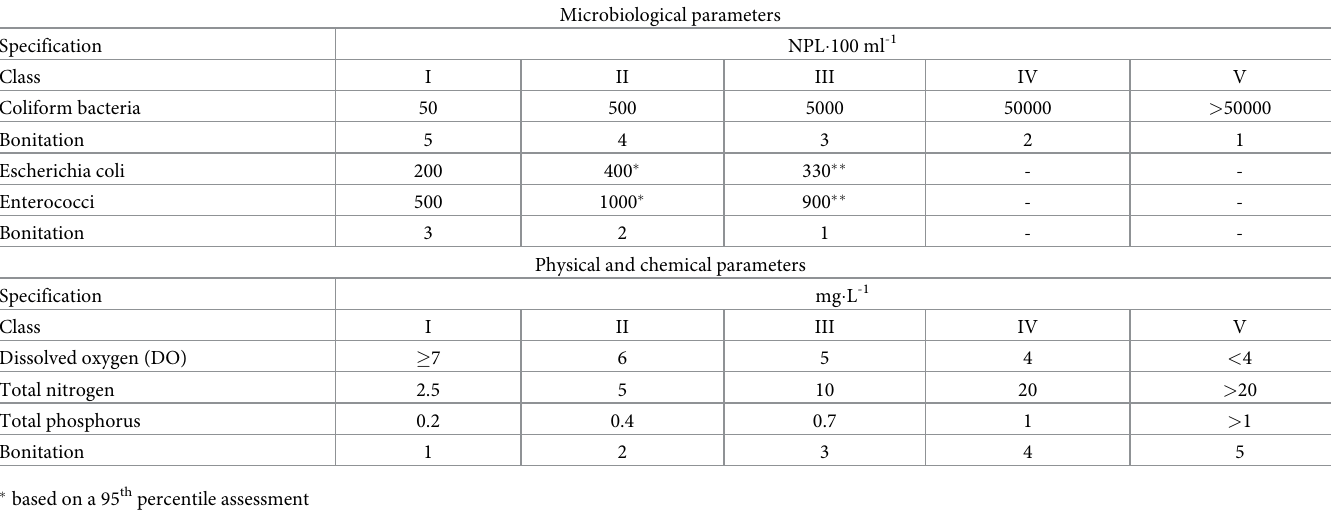
Table 1. Bonitation for selected microbiological and physico-chemical